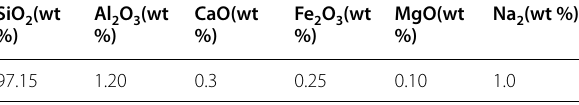
Table 2 Chemical composition of silicon powder SiO 2 (wt %)